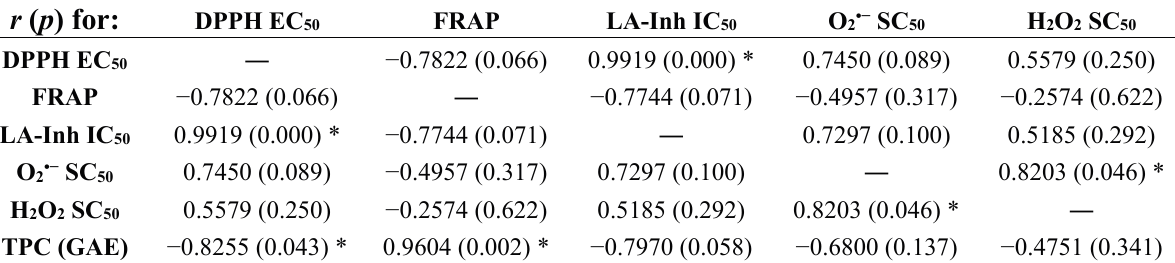
Table 2. Correlation ( r ) coefficients and probability ( p ) values of estimated linear relationships between antioxidant activity parameters and total phenolic contents of Gaultheria extracts a